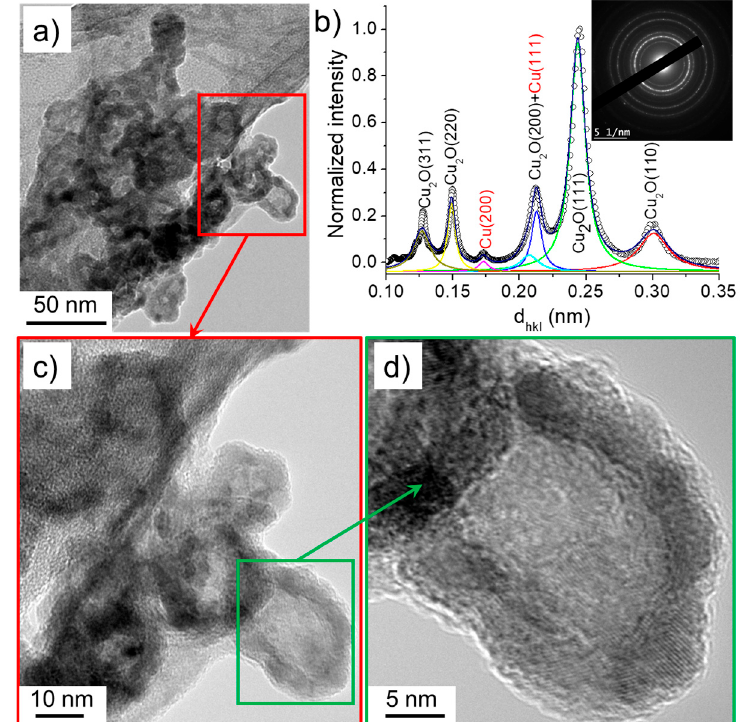
Figure 12. ( a ) TEM images of nanoparticles synthesized in the case 3 ( σ 0 = 32 µS/cm) and ( b ) the corresponding SAED pattern (performed on ( a )) radially integrated spectrum. ( c ) and ( d ) show the HR-TEM images of nanoparticles.